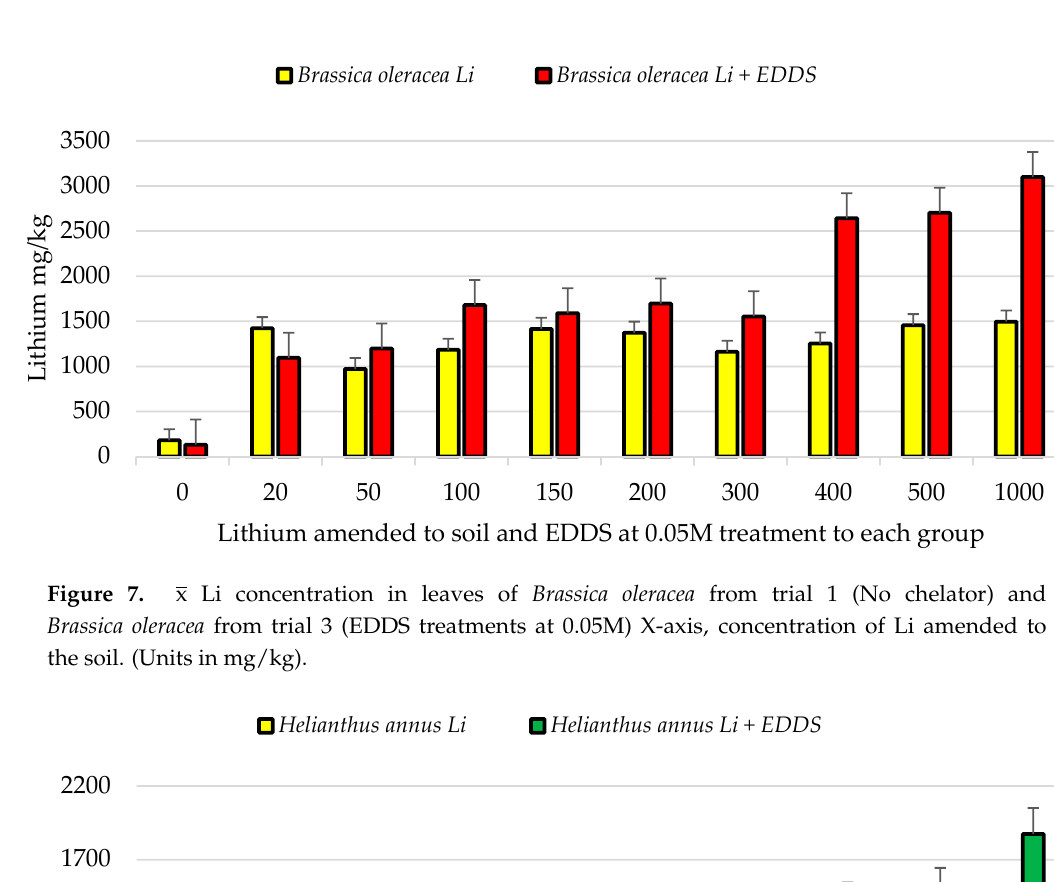
Figure 6. x ̅ Li concentration in leaves of Brassica napus from trial 1 (No chelator) and Brassica napus from trial 3 (EDDS treatments at 0.05M) X-axis, concentration of Li amended to the soil. (Units in mg/kg).